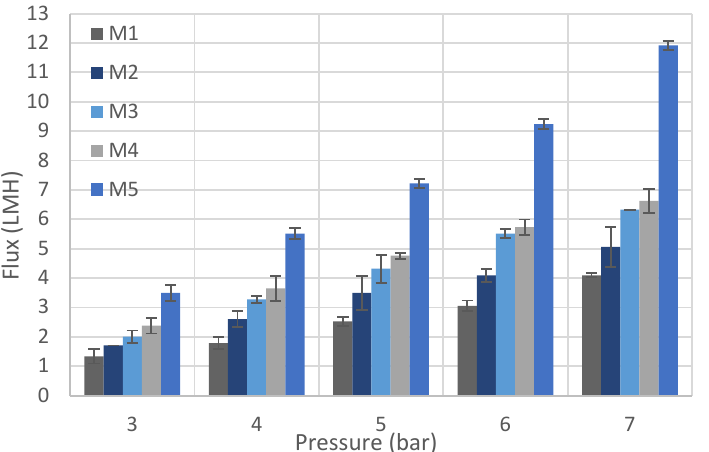
Figure 15. Pure water flux (PWF) for cast PSF/CNF membranes (test condition: room temperature, DI water).